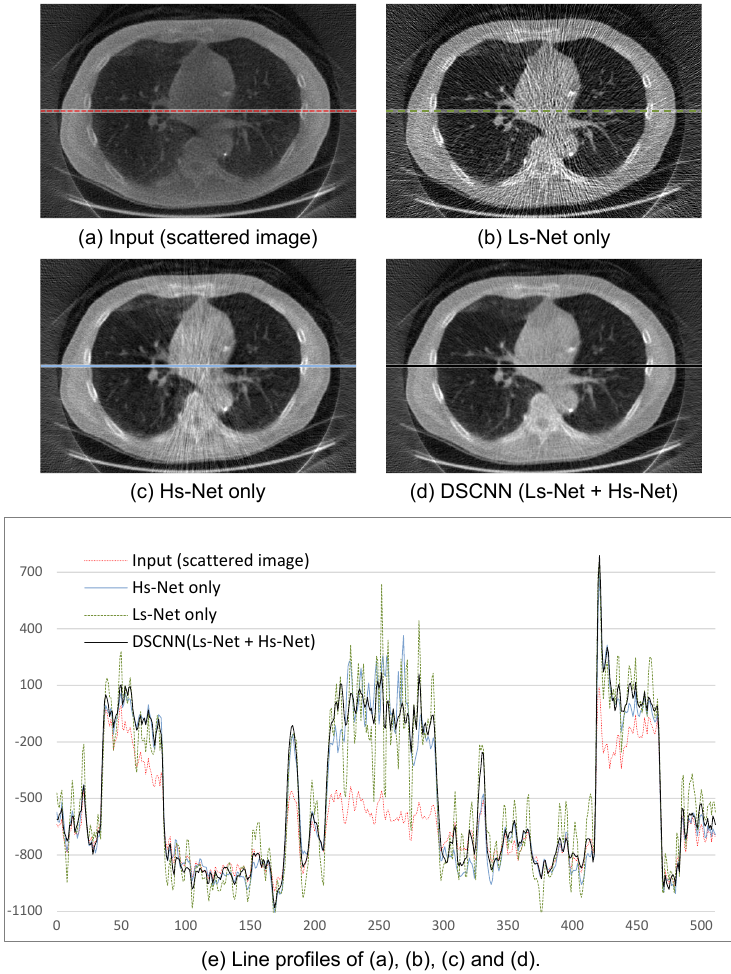
Figure 9. Performance of reconstructed images after scatter